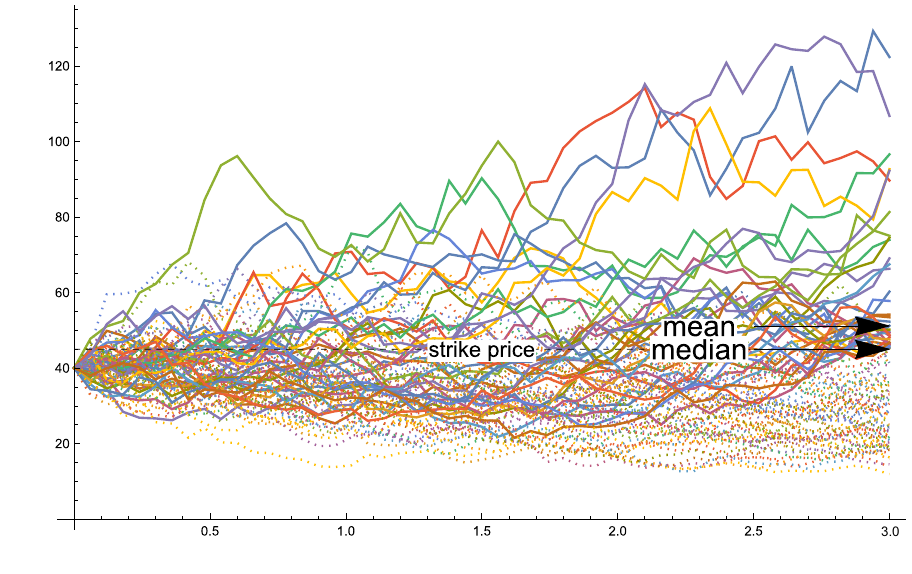
Fig. 4 Temporal variation of stock price S t as simulated by geometric Brownian motion (GBM) paths (starting price S 40 , strike price K = 45 , 0 = maturity time T = 3 , stock price volatility 𝜎 = 0.3 , risk-free interest rate r = 0.07 , stock dividend yield 𝛿 = 0 , and the number of time steps is 50). Among the total of 100 simulated paths, 67 paths end up with S T < K , which are displayed with dotted lines. An arrow with “mean” signifies the discounted mean of the option’s payoffs at expiry. An arrow with “median” is the median counterpart